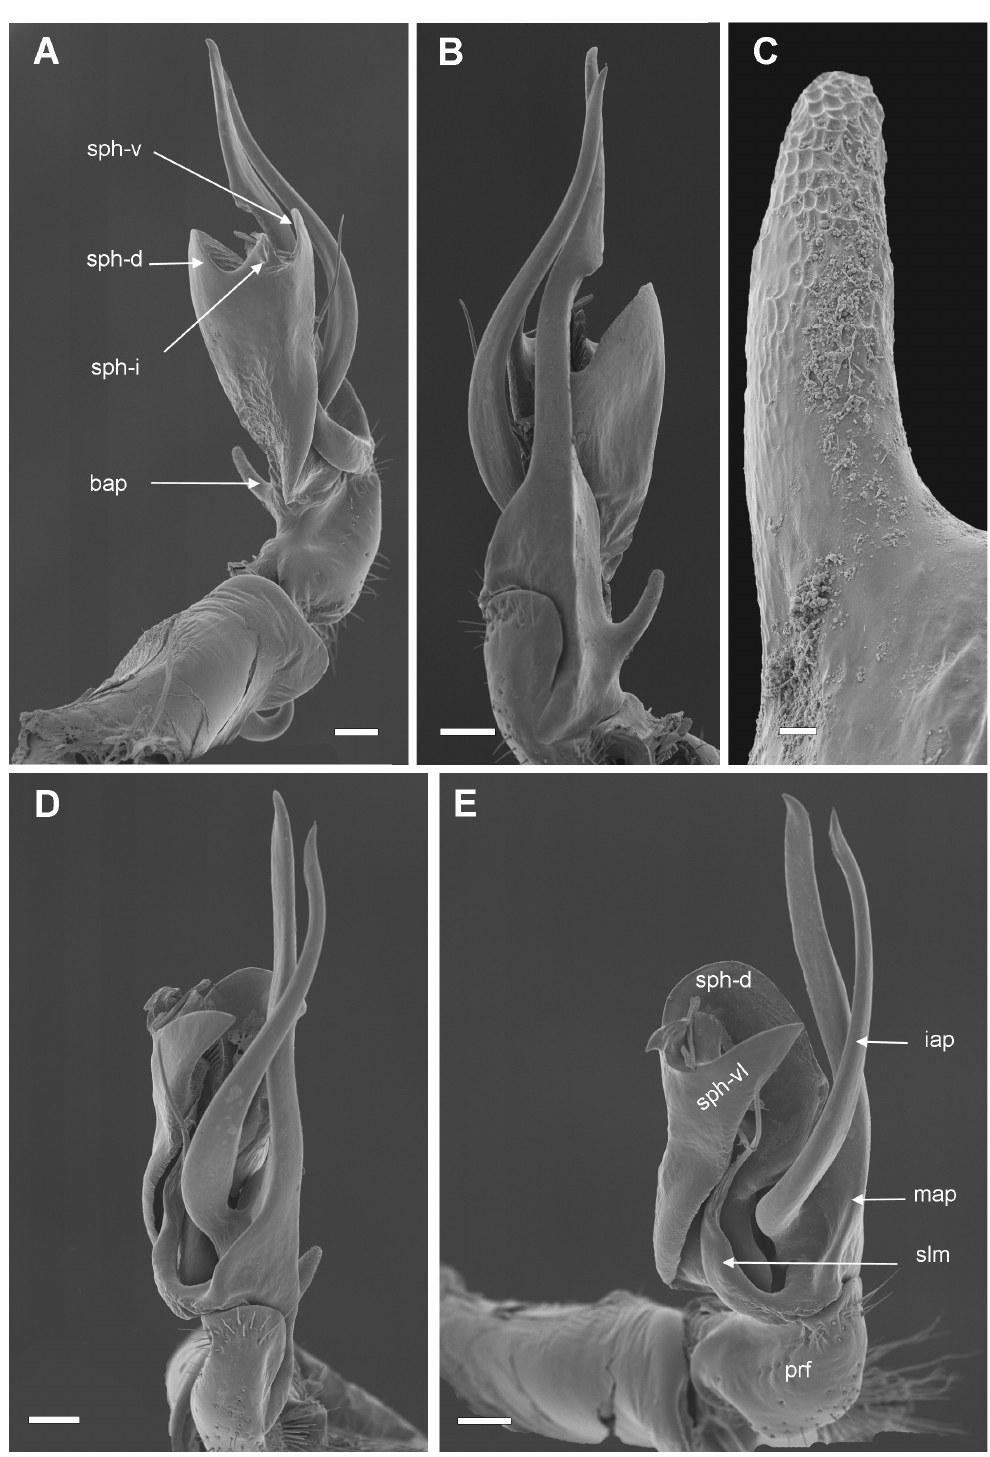
Fig. 9. Eviulisoma kwabuniense Kraus, 1958, ♂, non-type, from New Dabaga-Ulangambi FR, right gonopod. A . Dorso-lateral view. B . Dorso-mesal view. C . Close-up of basal acropodital process. D . Ventral view. E . Lateral view. Abbreviations: bap = basal acropodital process; iap = intermediate acropodital process; map = mesal acropodital process; prf = prefemoral part; slm = solenomere; sph-d , sph-i , sph-v = dorsal, intermediate and ventral lobes of solenophore. Scale bars: A–B, D–E = 0.1 mm; C = 0.01